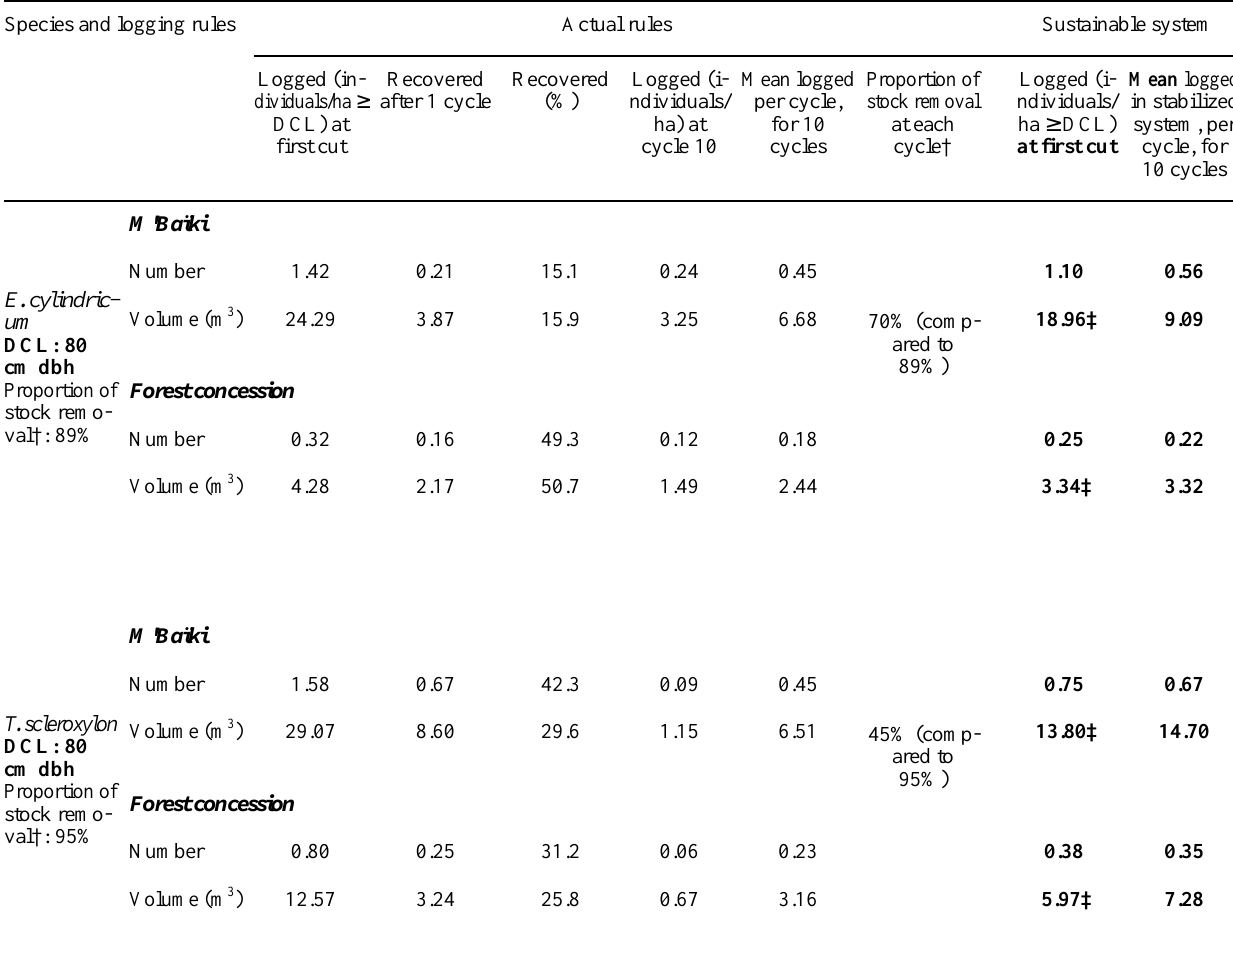
Table 1. Evolution of the exploitable stock of two main commercial species logged in the Central African Republic (CAR; Entandrophragma cylindricum and Triplochiton scleroxylon ) under the current felling